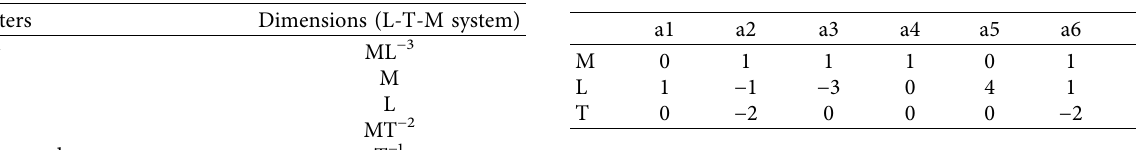
2: Dimension matrix of the